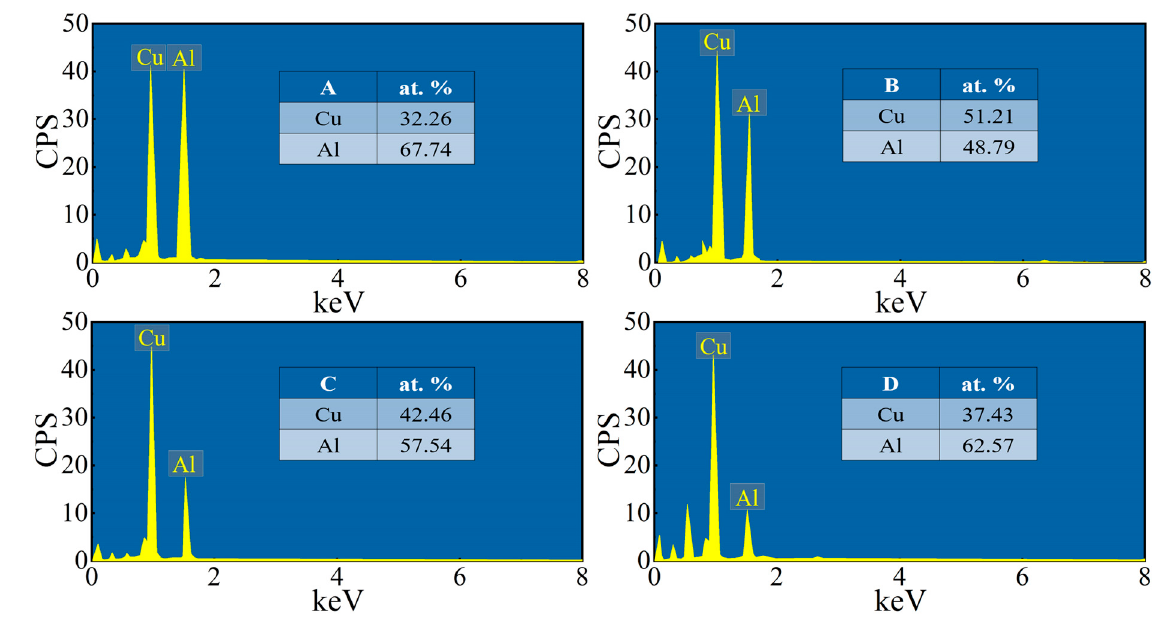
Figure 8. EDS result of point A-D in Figure 7b.